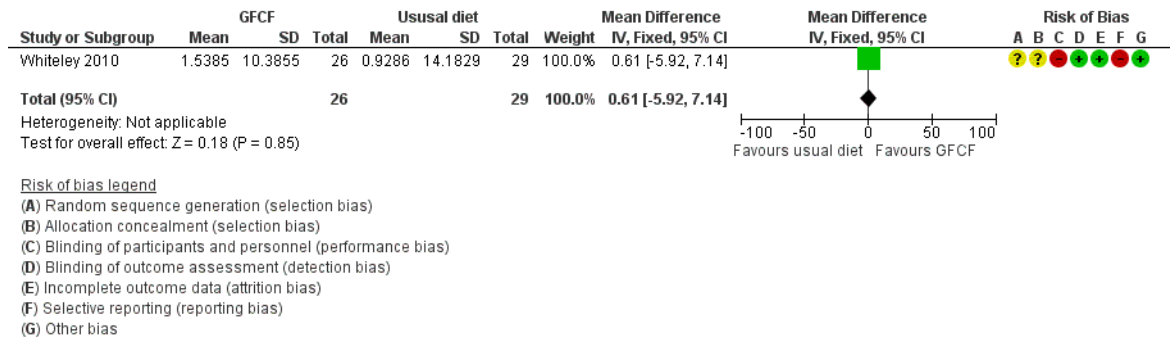
Figure 6. Forest plot of comparison: GFCF vs. usual diet, outcome: number of children with gastrointestinal discomfort.